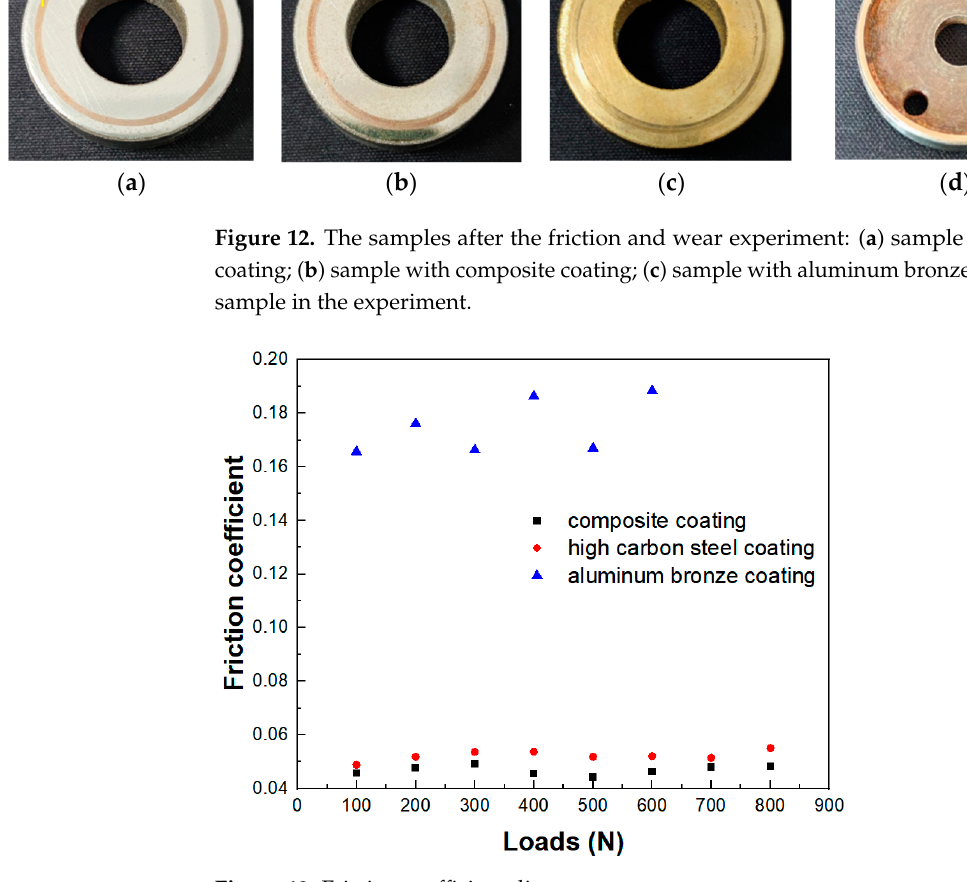
Figure 13. Friction coefficient diagram.